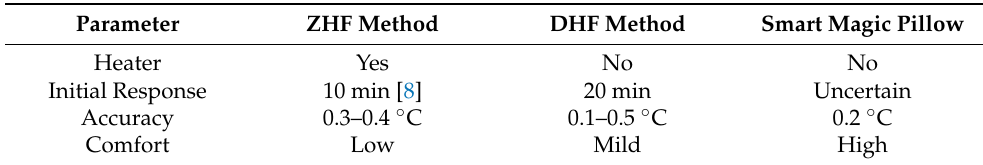
Table 3. Proven Non-invasive Technologies for Temperature